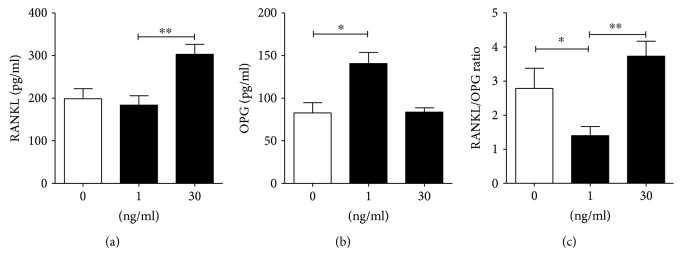
The levels of RANKL (a), OPG (b), and RANKL/OPG ratio (c) in PL cell cultures upon stimulation with IL-33. Periapical lesion (PL) cells were isolated from 12 PLs and cultivated for 24 hours with 1 ng/ml or 30 ng/ml of IL-33 as described in “Materials and Methods.” The levels of soluble RANKL and OPG in supernatants were measured by ELISA, and after that, the RANKL/OPG ratio was calculated. (a) Friedman test (n = 12, Friedman statistics 10.33, p = 0.0017) Dunn's multiple comparison test, ∗∗p < 0.01 as indicated. (b) Friedman test (n = 12, Friedman statistics 9.33, p = 0.0055) Dunn's multiple comparison test, ∗p < 0.05 as indicated. (c) Friedman test (n = 12, Friedman statistics 12.00, p = 0.0001) and Dunn's multiple comparison test, ∗p < 0.05 and ∗∗p < 0.01 as indicated.